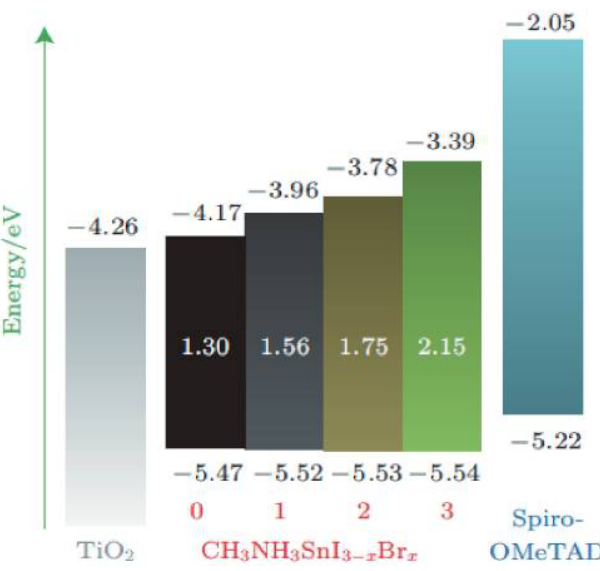
Figure 4. The relationship between Pb/Sn ratio and bandgap of perovskite [33].